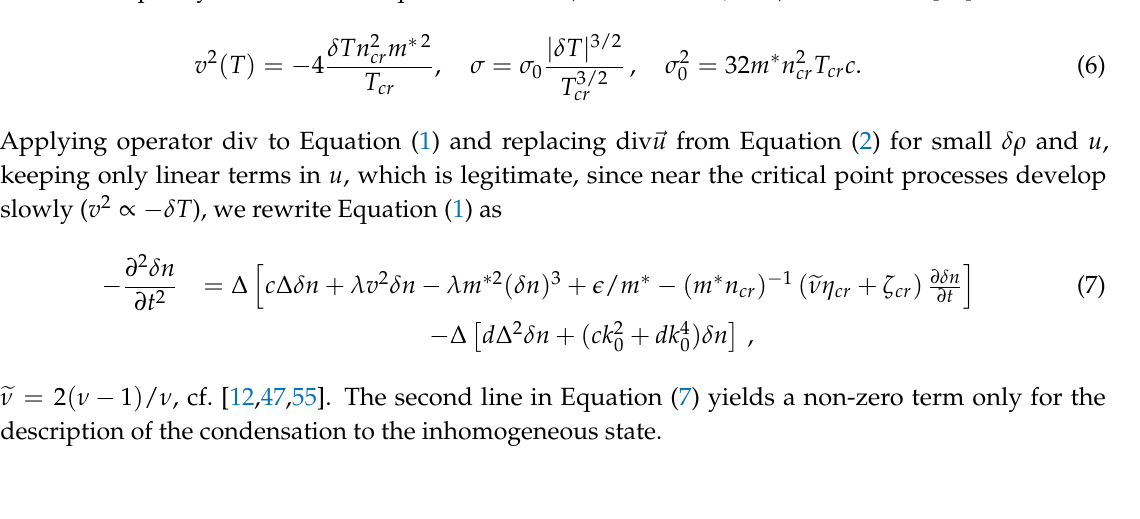
Figure 3. The Landau free energy density δ ρ cr δ [ F L ( T , δρ )] / P ( T cr , ρ cr ) , as functions of the order parameter δρ = m ∗ δ n for the EoS determined δ ( δρ ) | T by Equation (4), at T < T cr . The dashed horizontal line ( (cid:101) = 0) in the right panel shows MC, cf.